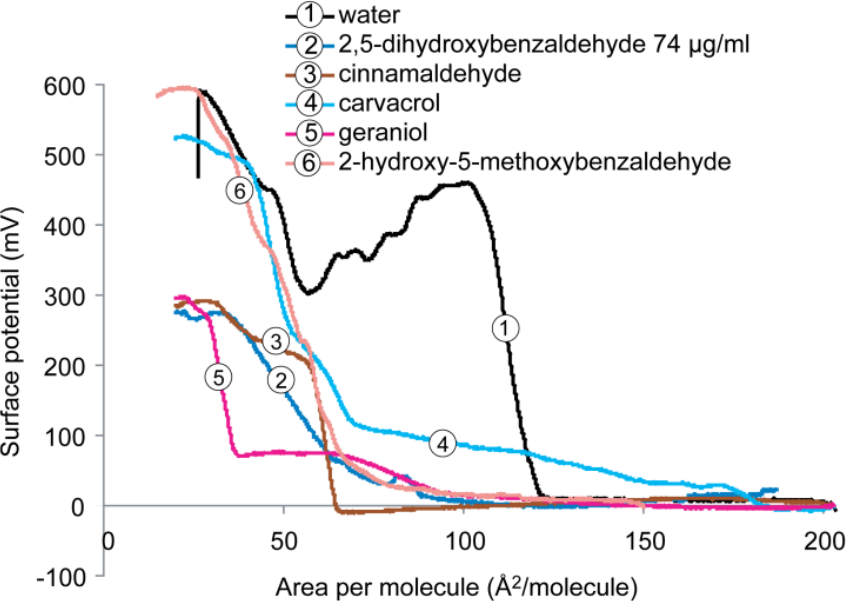
Figure 5. Surface potential versus molecular area recorded for the monolayers formed by DPPE on subphases containing water with and without